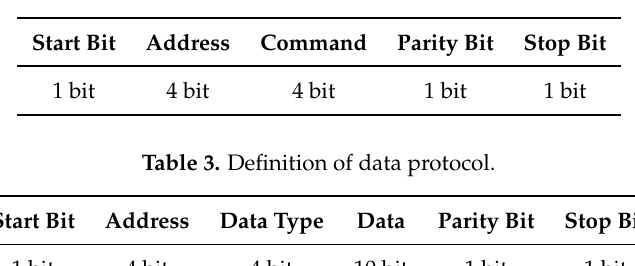
Table 2. Definition of command protocol.